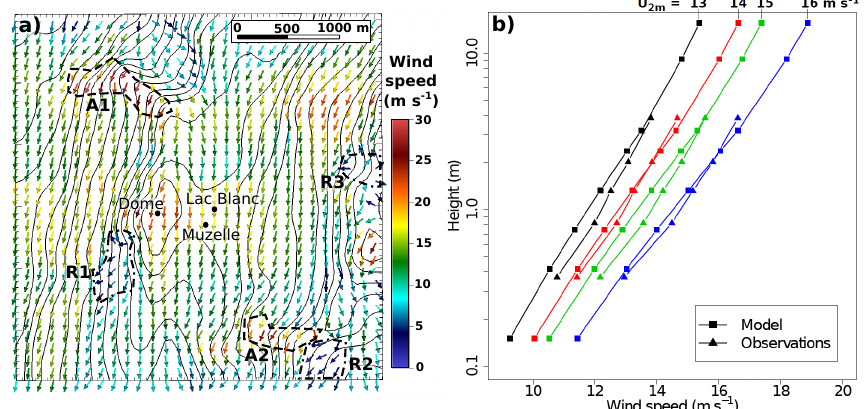
Fig. 7. (a) Wind field at 1st level of Meso-NH (variable height: 1.9–3.1m) on 18 March 2011 at 07:00: arrow indicates wind direction while colour indicates wind speed. Properties of wind field in dashed and dashed-dotted areas are discussed in the text. The black isolines correspond to 1z = 50m. (b) Comparison between averaged vertical profiles of wind speed simulated by the model and measured on a meteorological mast located at Col du Lac Blanc. Averaged vertical profiles have been computed for 4 categories of 2m wind speed. Canopy levels refer to the five lowest levels of the